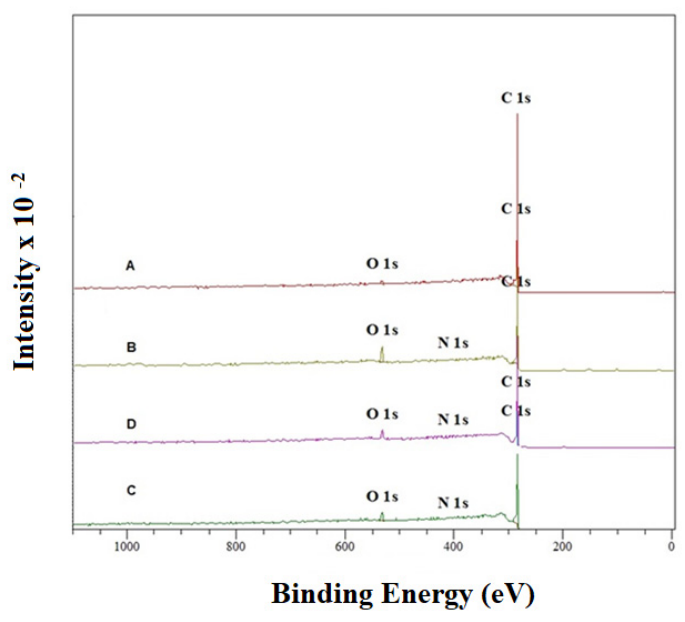
Figure 4. Wide-scan XPS of ( A ) MWCNT-COOH, ( B ) MWCNT-CONOHMe, ( C ) MWCNT-CONOHCOMe, and ( D ) MWCNT-CONOHCOPh.